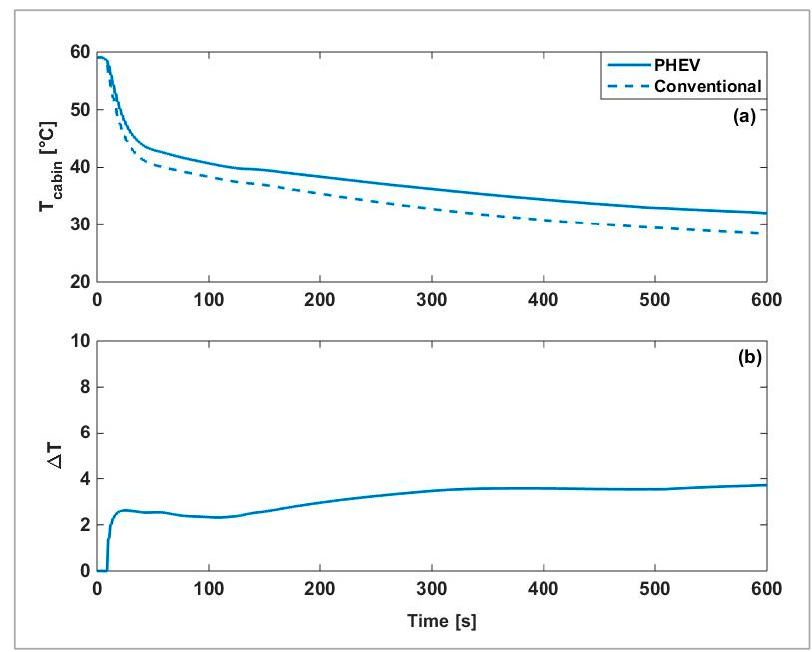
Figure 5. Simulation results: variations in ( a ) vehicle speed; ( b ) engine torque; ( c ) battery SoC and ( d ) the temperature of the cabin and battery over the trips.